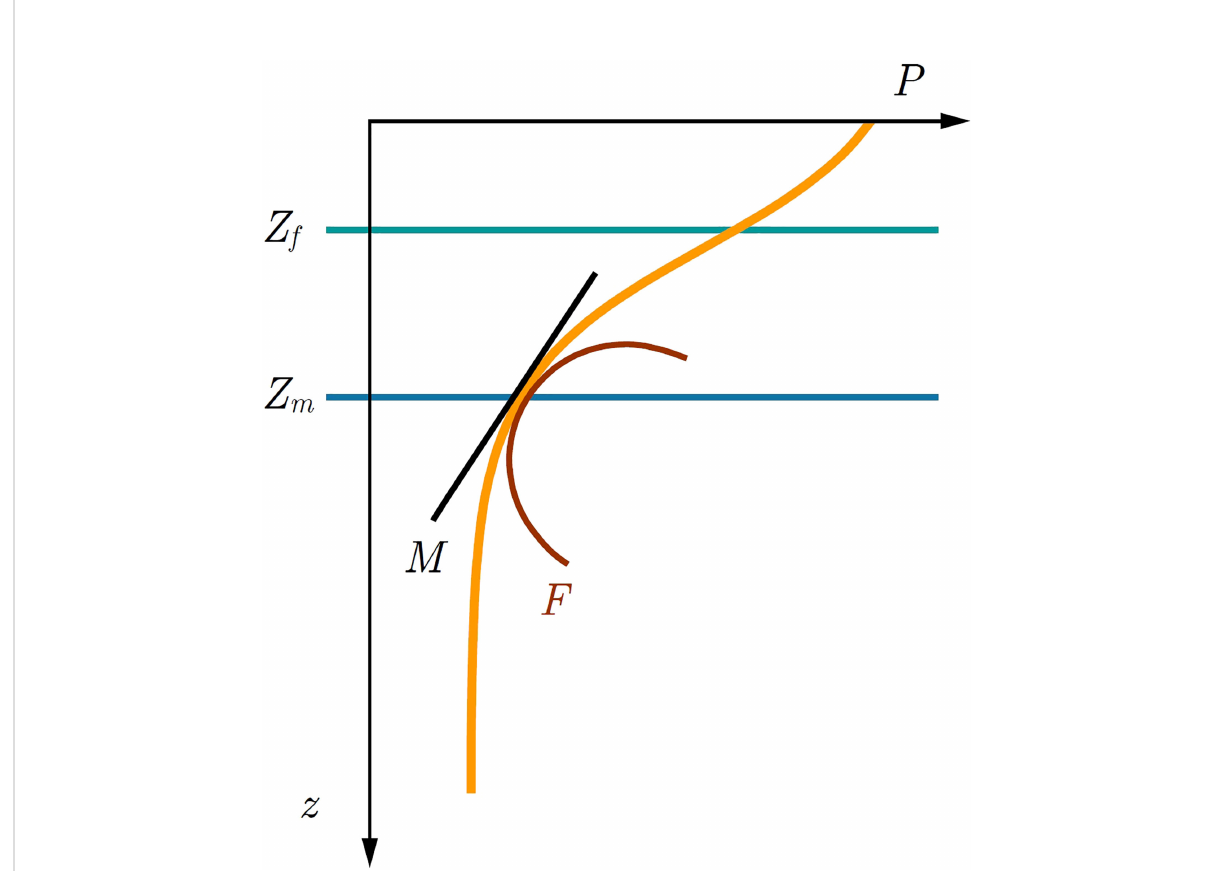
FIGURE 3 Graphical representation of marginal mixed-layer production and mixed-layer production fragility. Orange curve represents average mixed-layer production 〈 P 〉 Zm , T as a function of depth (23). For a given mixed-layer depth Z m (blue line) marginal production M Z equals the fi rst derivative of 〈 P 〉 Zm , T with respect to Z m and is indicated by the tangent (black line) and fragility is indicated by the curvature (red curve). Above Z the system is fragile, whereas below it the system is antifragile. Graphically, Z f corresponds to the in fl exion point and satis fi es condition